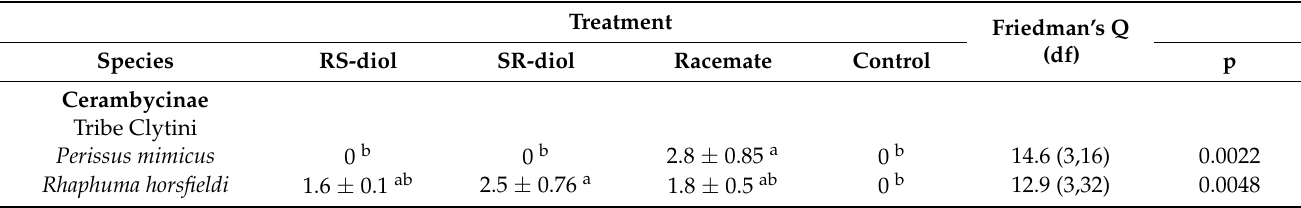
Table 2. Numbers (mean ± SE) of beetles caught in traps baited with (2 R ,3 S )-2,3-octanediol (RS-diol), (2 S ,3 R )-2,3-octanediol (SR-diol), racemic anti -2,3-octanediol (racemate), or a solvent control ( R and S denote the configuration of the chiral center). Different letters (a, b) indicate significant different in mean numbers of beetles captured.